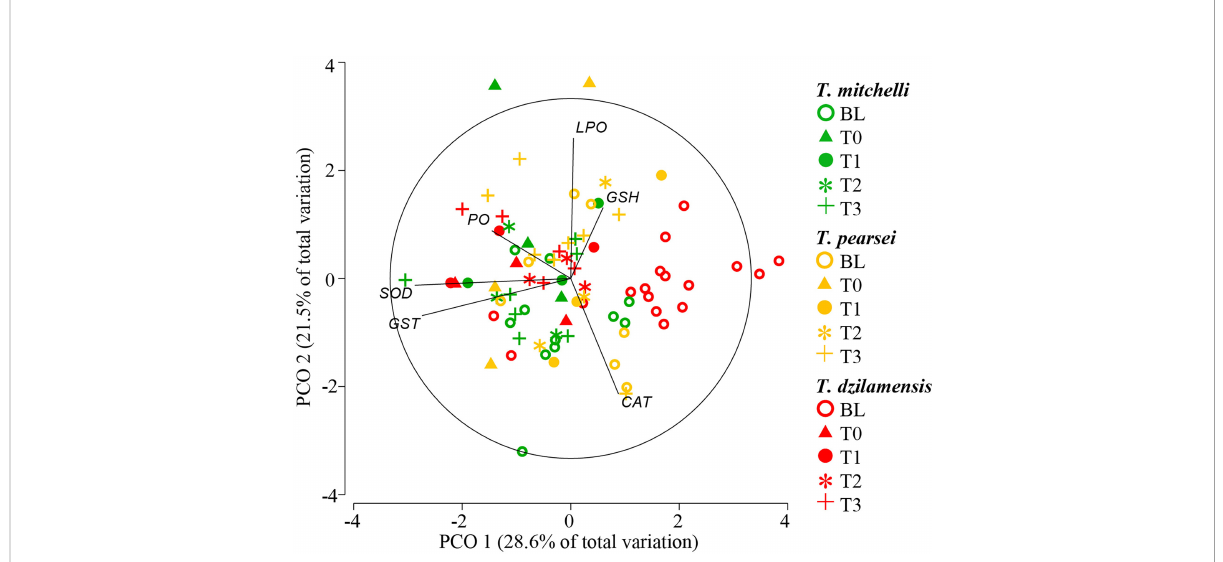
FIGURE 3 Principal coordinate analysis (PCoA) of antioxidant system indicators (CAT, GST, GSH and SOD) and cell damage (PO and LPO) from untreated (BL) T. mitchelli , T. pearsei and T. dzilamensis and individuals sampled 0, 30, 60 and 120 minutes (T0 to T3) after induced